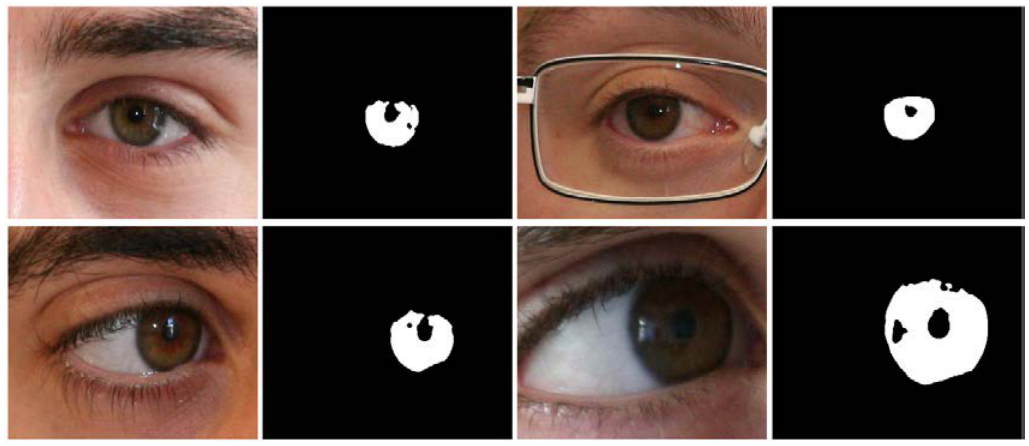
Figure 5. Noisy iris challenge evaluation part-II (NICE-II) sample images with corresponding ground truths.